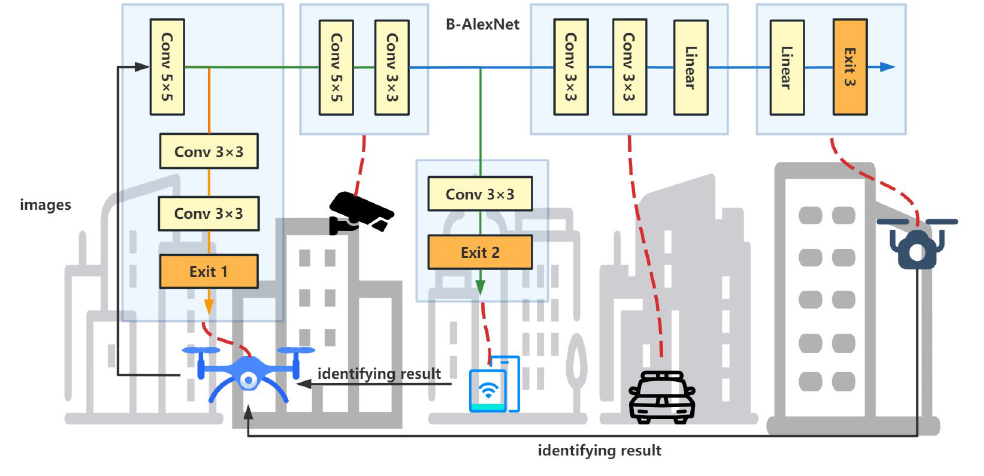
Figure 1. Illustration of a distributed DNN inference by collaboration among multiple edge